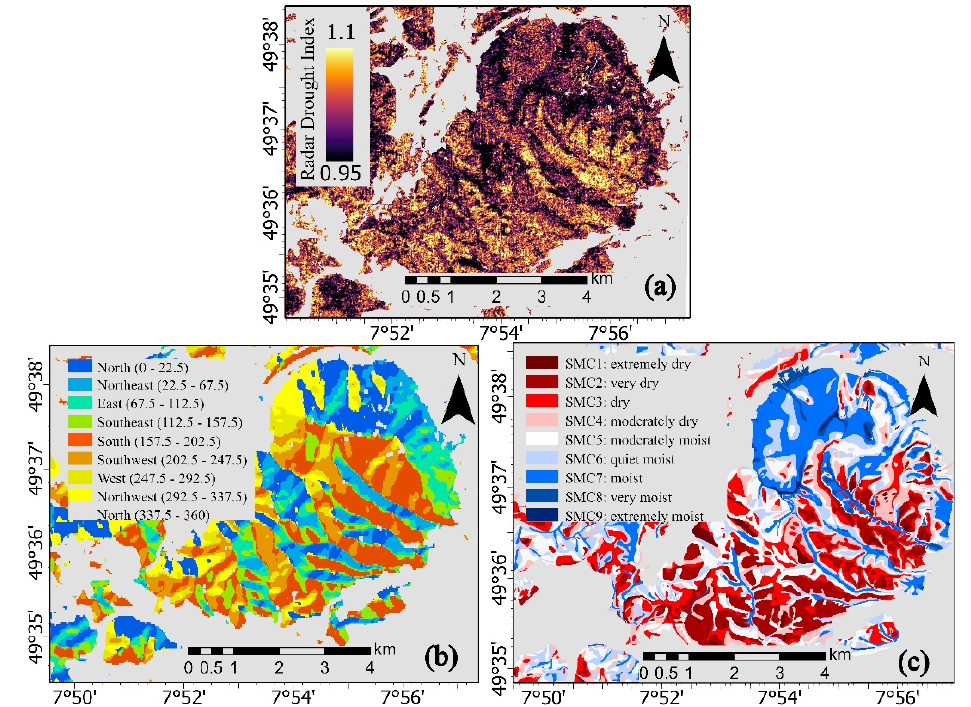
Figure 14. Comparison between ( a ) Spatially high-resolution RDI map for 2020, ( b ) Aspect and ( c ) Soil moisture classes at the Donnersberg area.